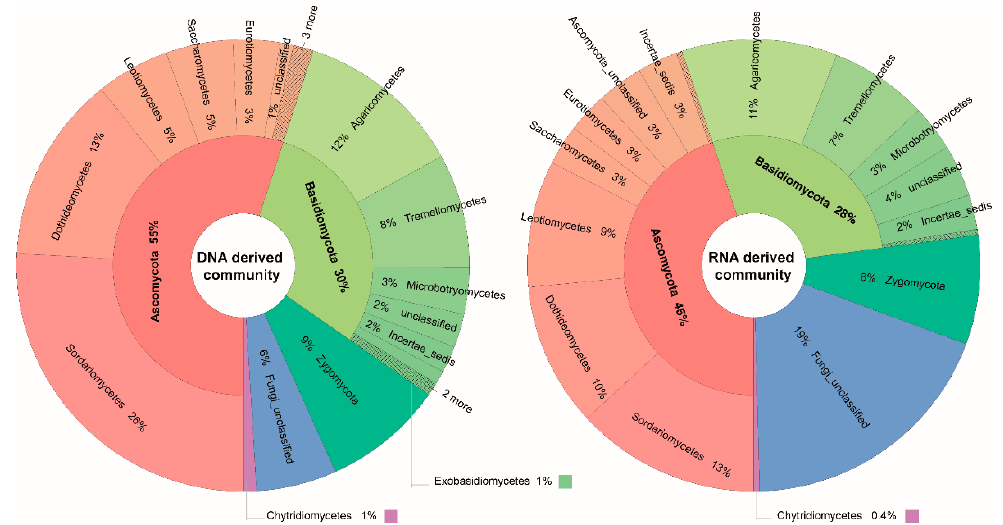
Figure 3. Krona charts illustrating the taxonomic distribution of fungal OTUs at phylum and class level, detected in the DNA- and RNA-derived communities from a subsurface aquatic habitat. 255